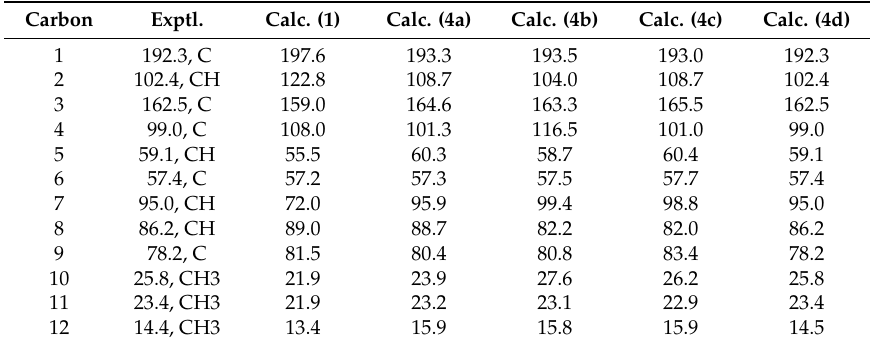
Table 1. Comparison of experimental vs. calculated 13 C-NMR chemical shifts for acremine P ( 4 ). 1